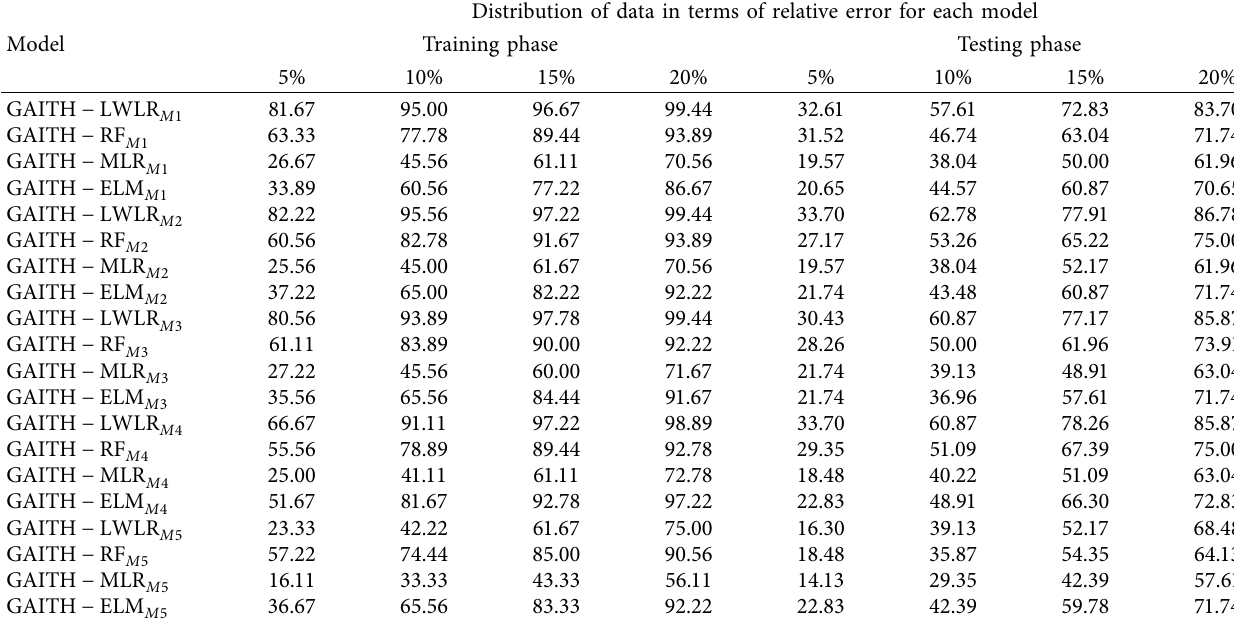
Table 8: A comparison between the suggested models’ efficiency in the presence of GAITH.